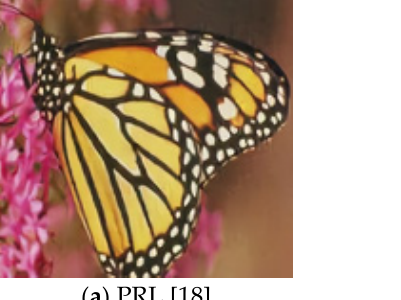
Table 4. Comparison on PSNR/SSIM obtained by different methods.